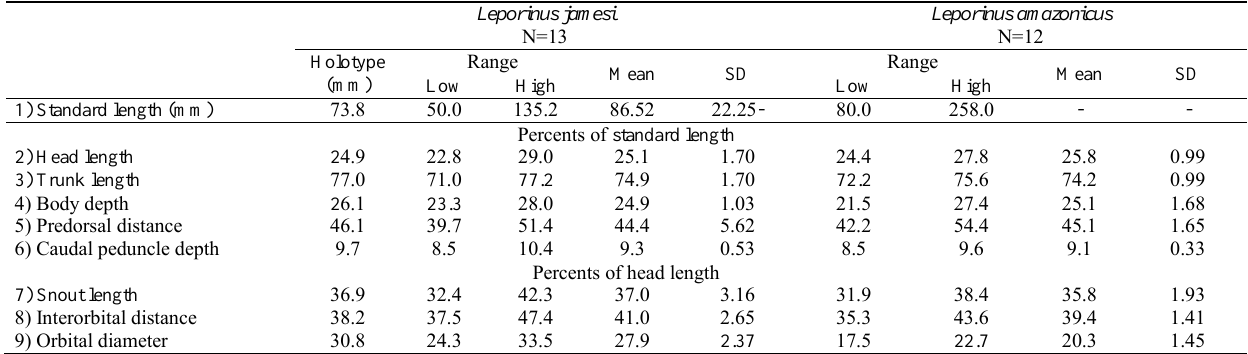
Table 1. Morphometrics of Leporinus jamesi and L. amazonicus . SD = standard deviation, N = number of